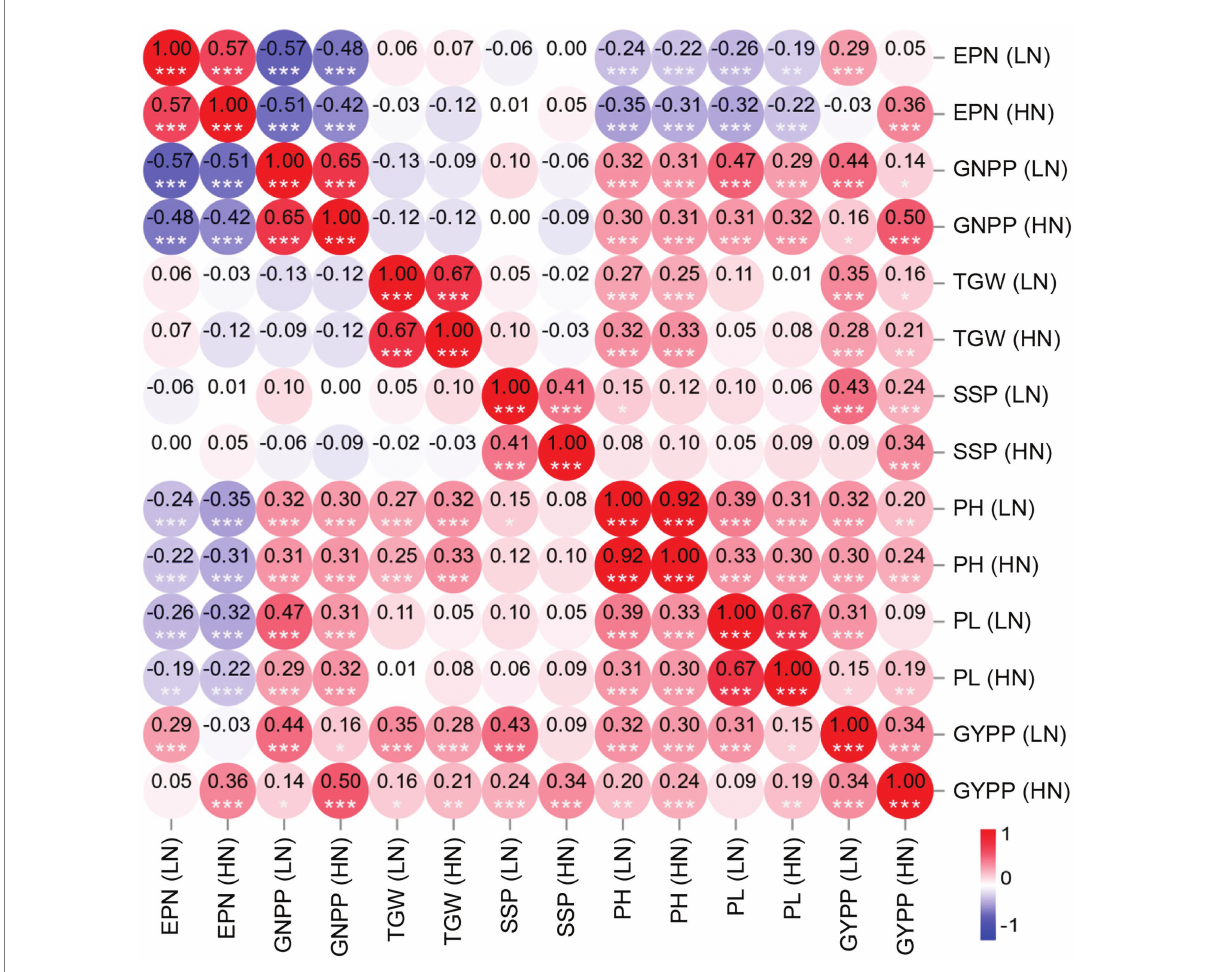
FIGURE 2 Heatmap of the correlations among the agronomic traits of the RIL population under two N levels. The color bar indicates the Pearson’s correlation coefficients, which are shown in the circles. *** p < 0.001, ** p < 0.01, and * p < 0.05. EPN, effective panicle number; GNPP, grain number per panicle; TGW, thousand-grain weight; SSP, seed-setting percentage; PH, plant height; PL, panicle length; LN, low nitrogen; HN, high